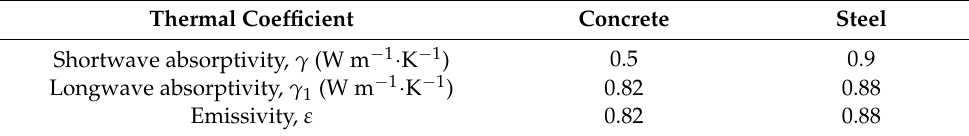
Table 2. Thermal coefficients adopted in the temperature